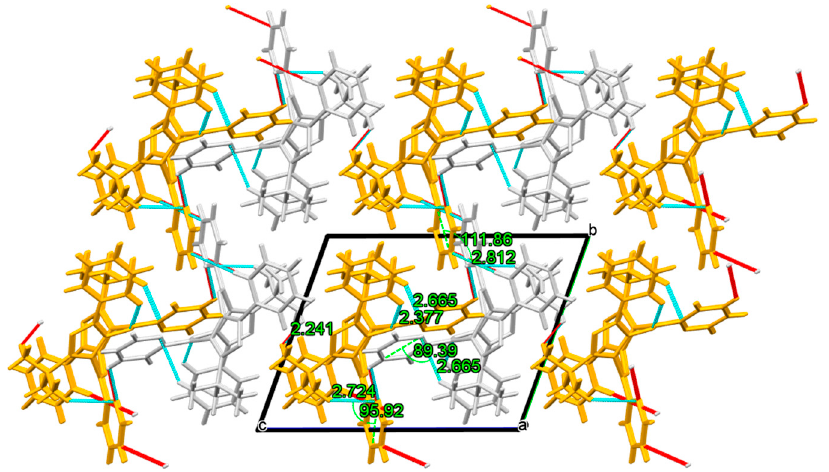
Figure 4. Crystal packing (2.5 × 2.5 × 2.5 supercell) of 1,5-diazocine 8 seen along the bc face and highlighting featured N···H HBs. Molecular units ( Z = 2, Z ′ = 1) are colored based on different symmetry operations. Intramolecular HBs are shown in cyan, while intermolecular HBs are shown in red. Distances in Angstroms (Å) and angles in grades (°).